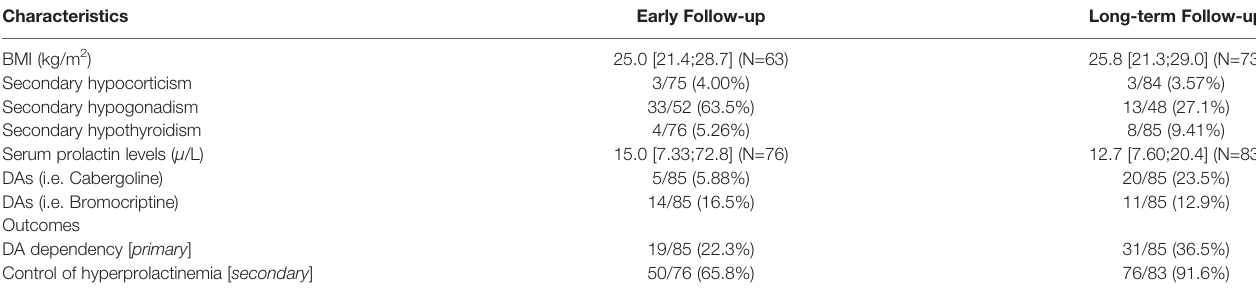
TABLE 2 | Patients ’ characteristics at early (30 days postoperatively) and long-term follow-up.